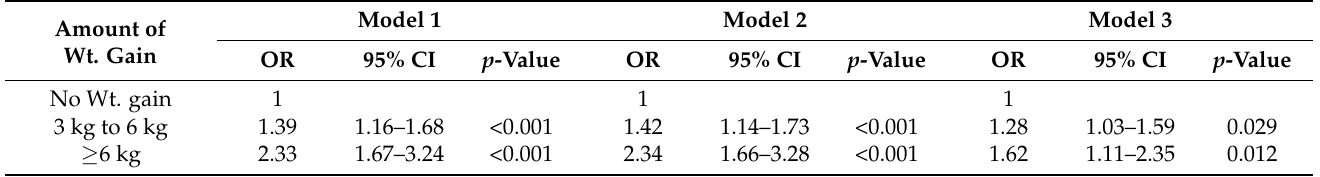
Table 4. Association between amount of weight gain and knee pain using multiple logistic regression.